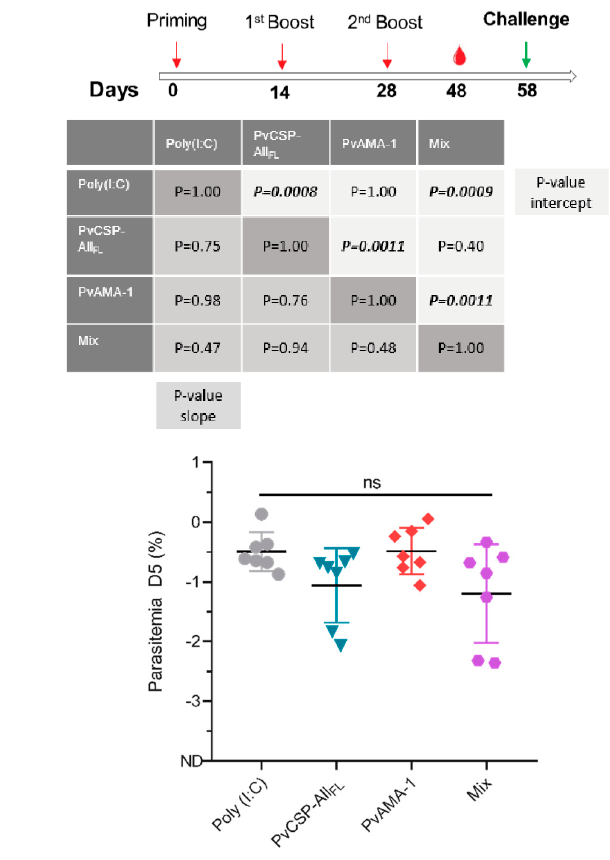
Figure 7. Evaluation of parasitemia after challenge in immunized mice. Groups of female C57BL / 6 mice aged 6–8 weeks (n = 7) were immunized (s.c.) with 10 µ g of each recombinant protein and poly(I:C) (50 µ g / dose). On day 58 after priming, the mice were challenged with 5000 Pb / PvCSP-VK210 transgenic sporozoites ( A ). Parasitemia was analyzed by flow cytometry. The percentage of infected red blood cells (iRBCs) on days 4, 5, and 6 postinfection (p.i.) was expressed as log values for